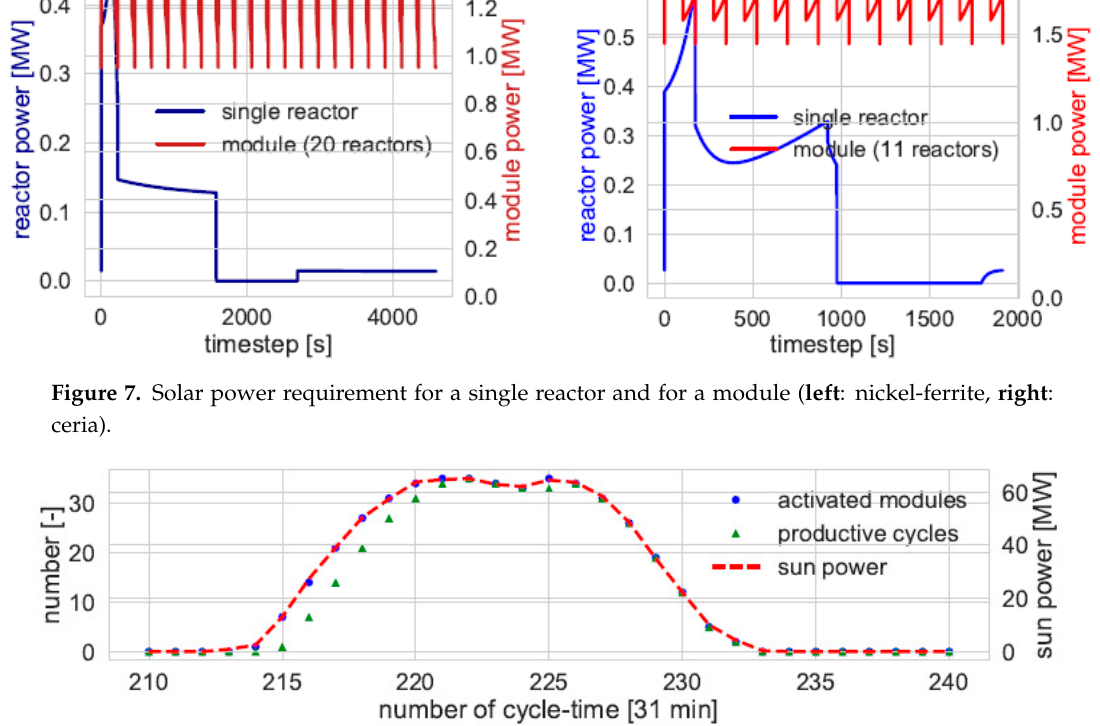
Figure 8. Plant daily performance (ceria, typical day, base case).